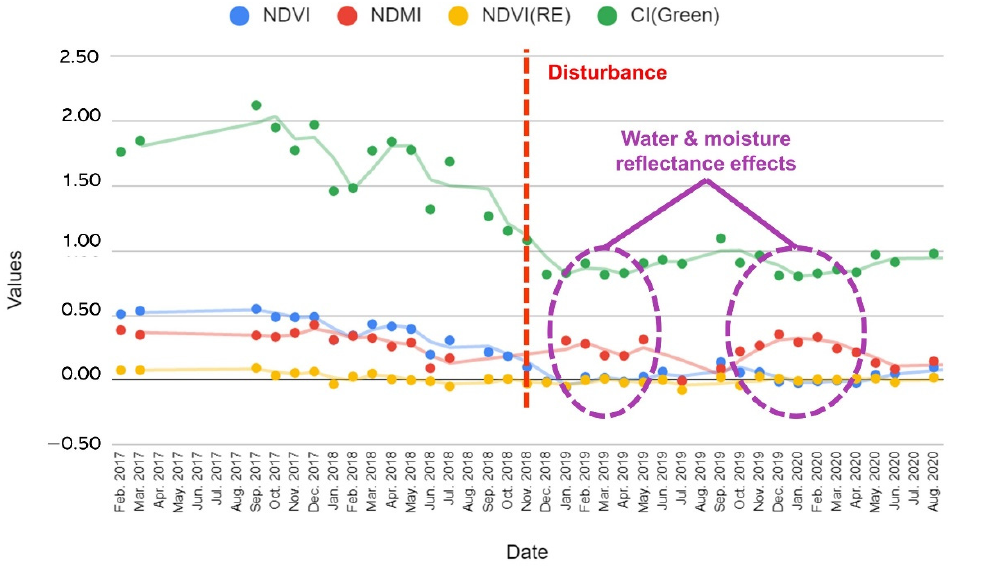
Figure 7. Comparison of Mangrove Vegetation Indices—Stage Change from Healthy to Disturbance using Sample Plot ID2. Disturbance to healthy mangrove stage using the sample plot ID376.